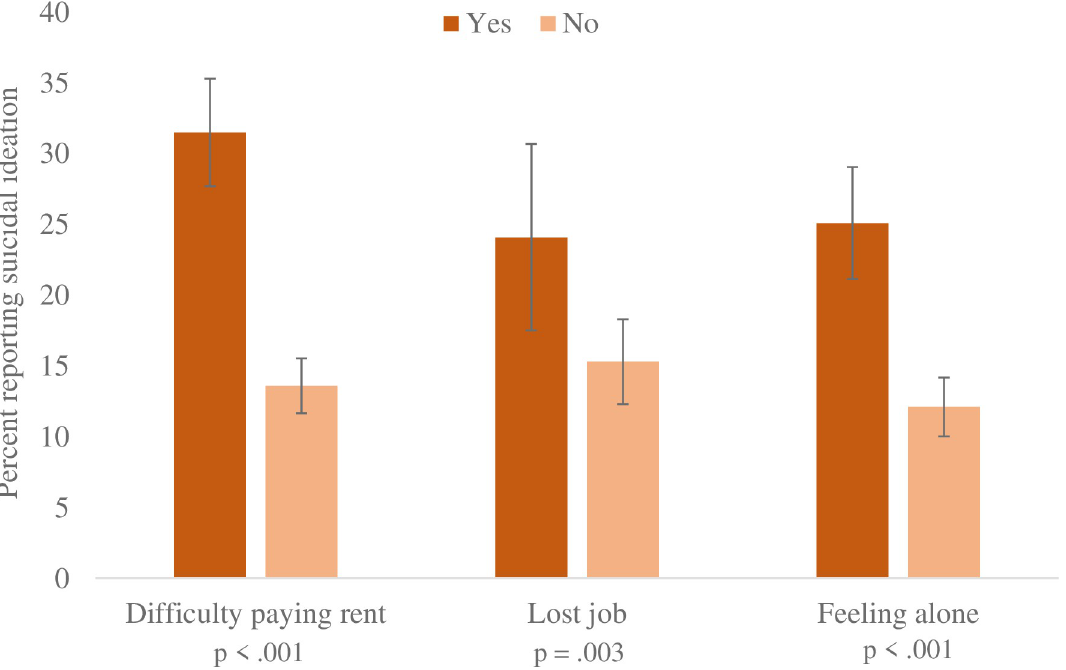
Fig 1. COVID-19 stressors and suicidal ideation. The figure depicts the percentages with 95% confidence intervals of participants who reported suicidal ideation among those who did or did not report COVID-19-related stressors, including difficulty paying rent, losing a job, and feeling alone. Data used to create the figure comes from the COVID-19 and Life Stressors Impact on Mental Health and Well-being (CLIMB) study conducted from March 31, 2020 through April 13,